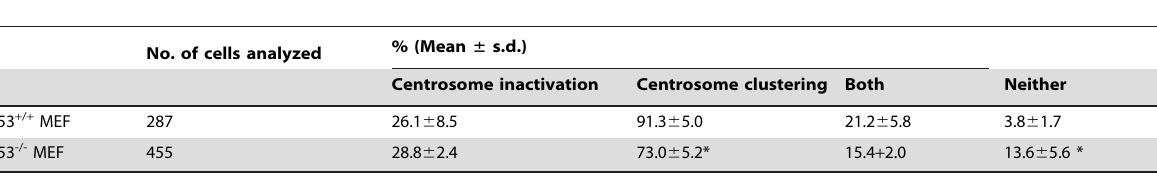
Table 1. Centrosome clustering was impaired in p53 -/- MEF cells with extra centrosomes.